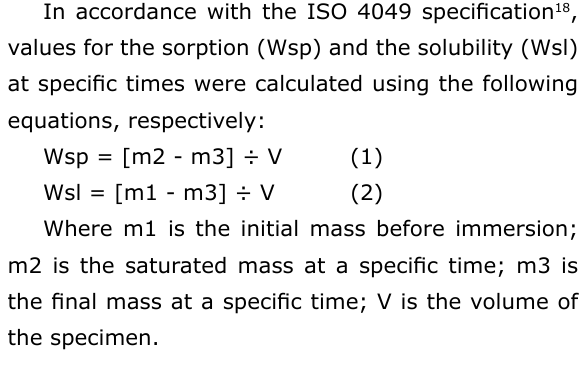
Table 1- Mean (standard deviation) Knoop microhardness of conventional and self-adhesive resin cements